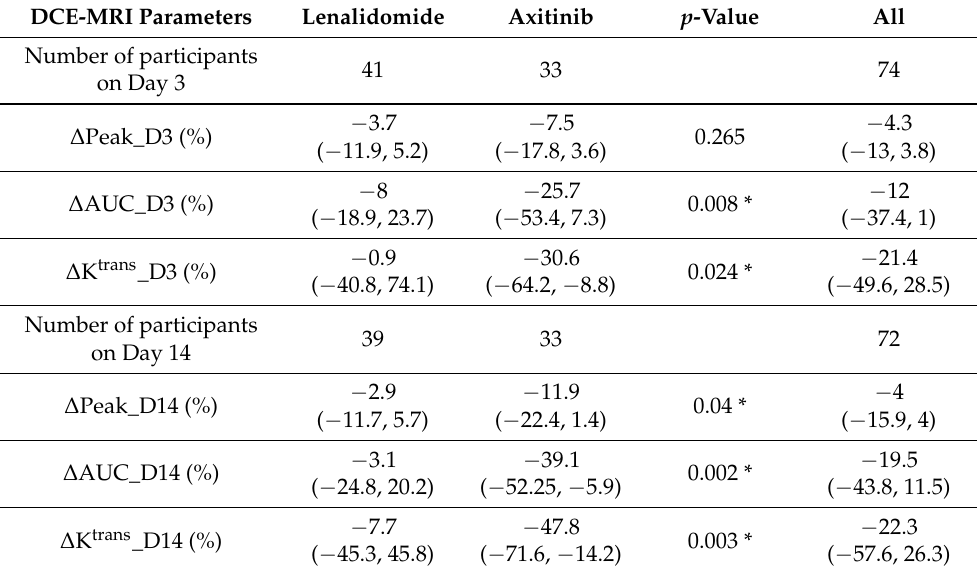
Table 2. Comparison of changes in the DCE-MRI parameters between lenalidomide and axitinib between day 3 and day 14. DCE-MRI Parameters Lenalidomide Axitinib p -Value All Number of participants on Day